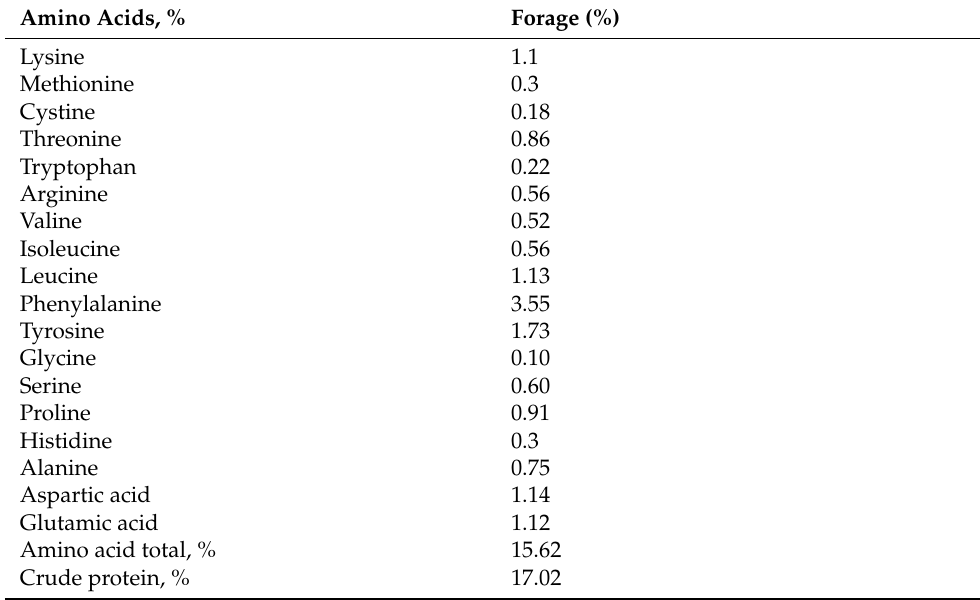
Table 5. Amino acid content of the forage meal (leaves + petioles + stems) of Hibiscus rosa-sinensis (100% DM). Amino Acids,